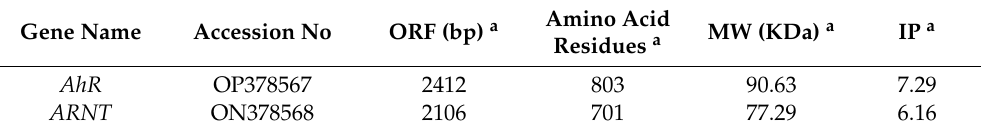
Table 1. Physicochemical properties of putative D. armandi AhR and ARNT